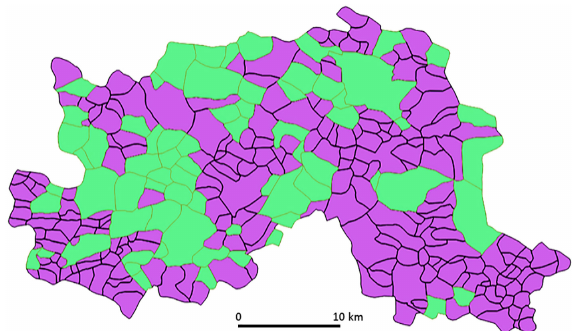
Fig. 14. Visualisation of cleaned and uncleaned data